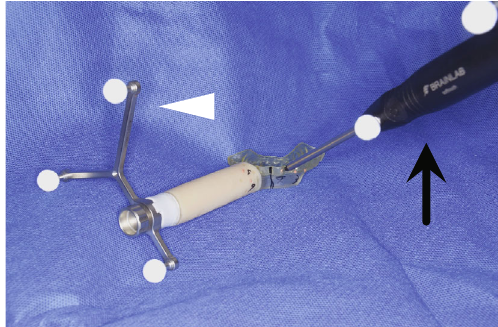
Figure 6: Marker-based pair-point registration using the custom- made splint, which is integrated with the reference frame and registration markers. The reference frame (white arrowhead) is fi xed to the connector of the splint. The numbered landmarks (the 11 gutta-percha markers) are indicated within the optical tracking range of the navigation system and registered point-by-point in succession, using the pointer (black